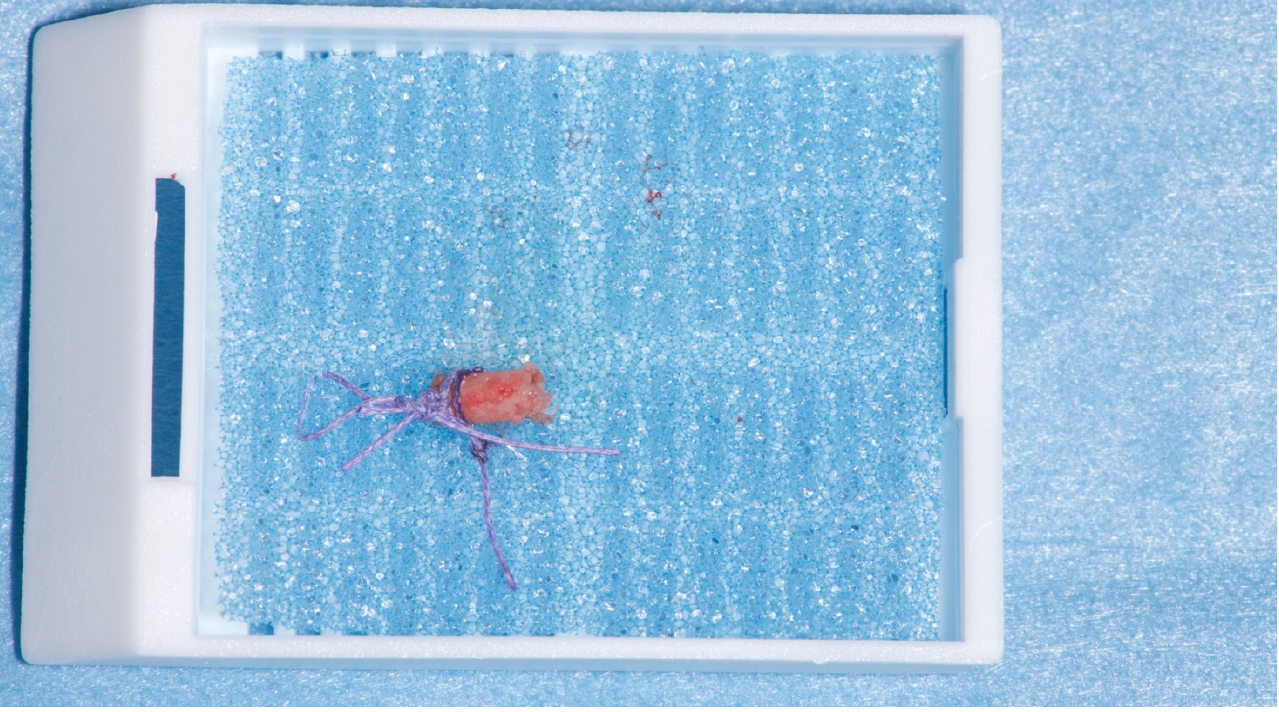
Figure 9. Example of collected sample. A suture was placed to immobilize the sample and to define the most occlusal part of the sample itself.